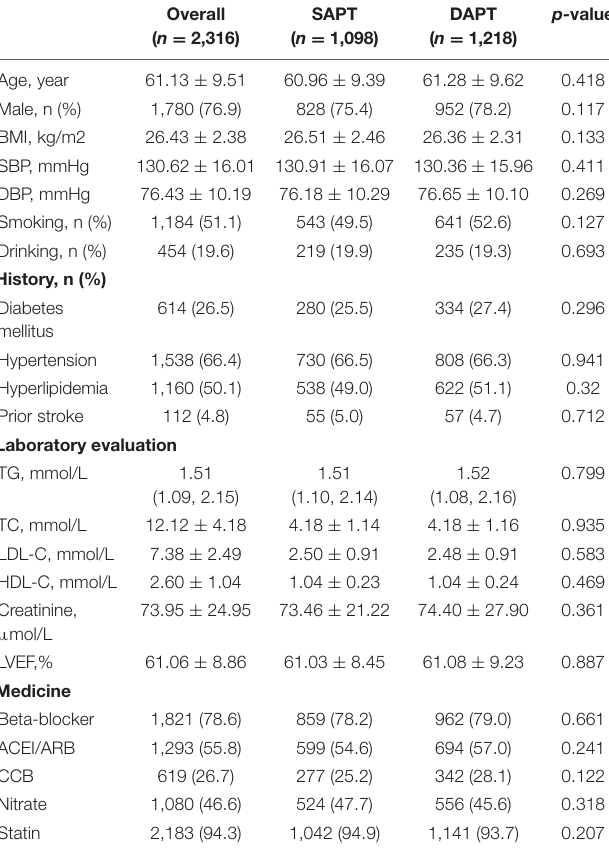
Table 2 . Except for CAD (28.5 vs. 73.7%, p < 0.001), there were